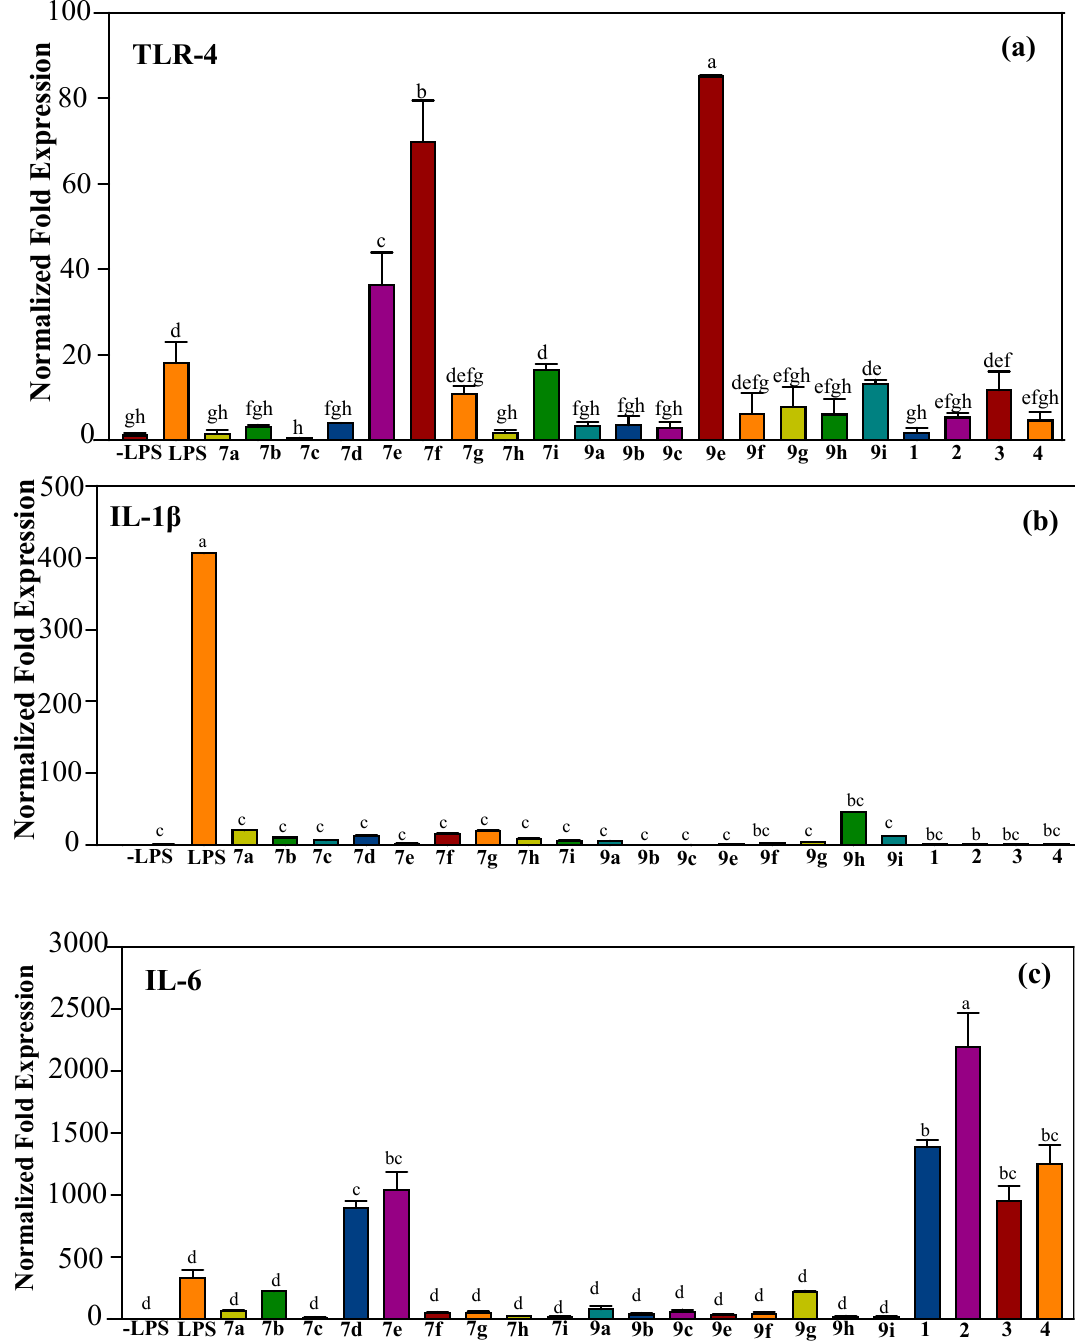
Figure 7. mRNA expression of ( a ) TLR-4, ( b ) IL-1 β , and ( c ) IL-6. RAW 264.7 cells were pre-treated with synthetic or natural compounds (10 µ g/mL) for 1 h before induction of inflammation by LPS (1 µ g/mL) for 6 h. Values indicate means ± SD. Bars with the same letters are not significantly different ( α = 0.05). LPS: lipopolysaccharide; 7a – i are synthetic halo-substituted chalcones; 9a – i are synthetic halo-substituted azachalcones; 1 – 4 are synthetic natural products.